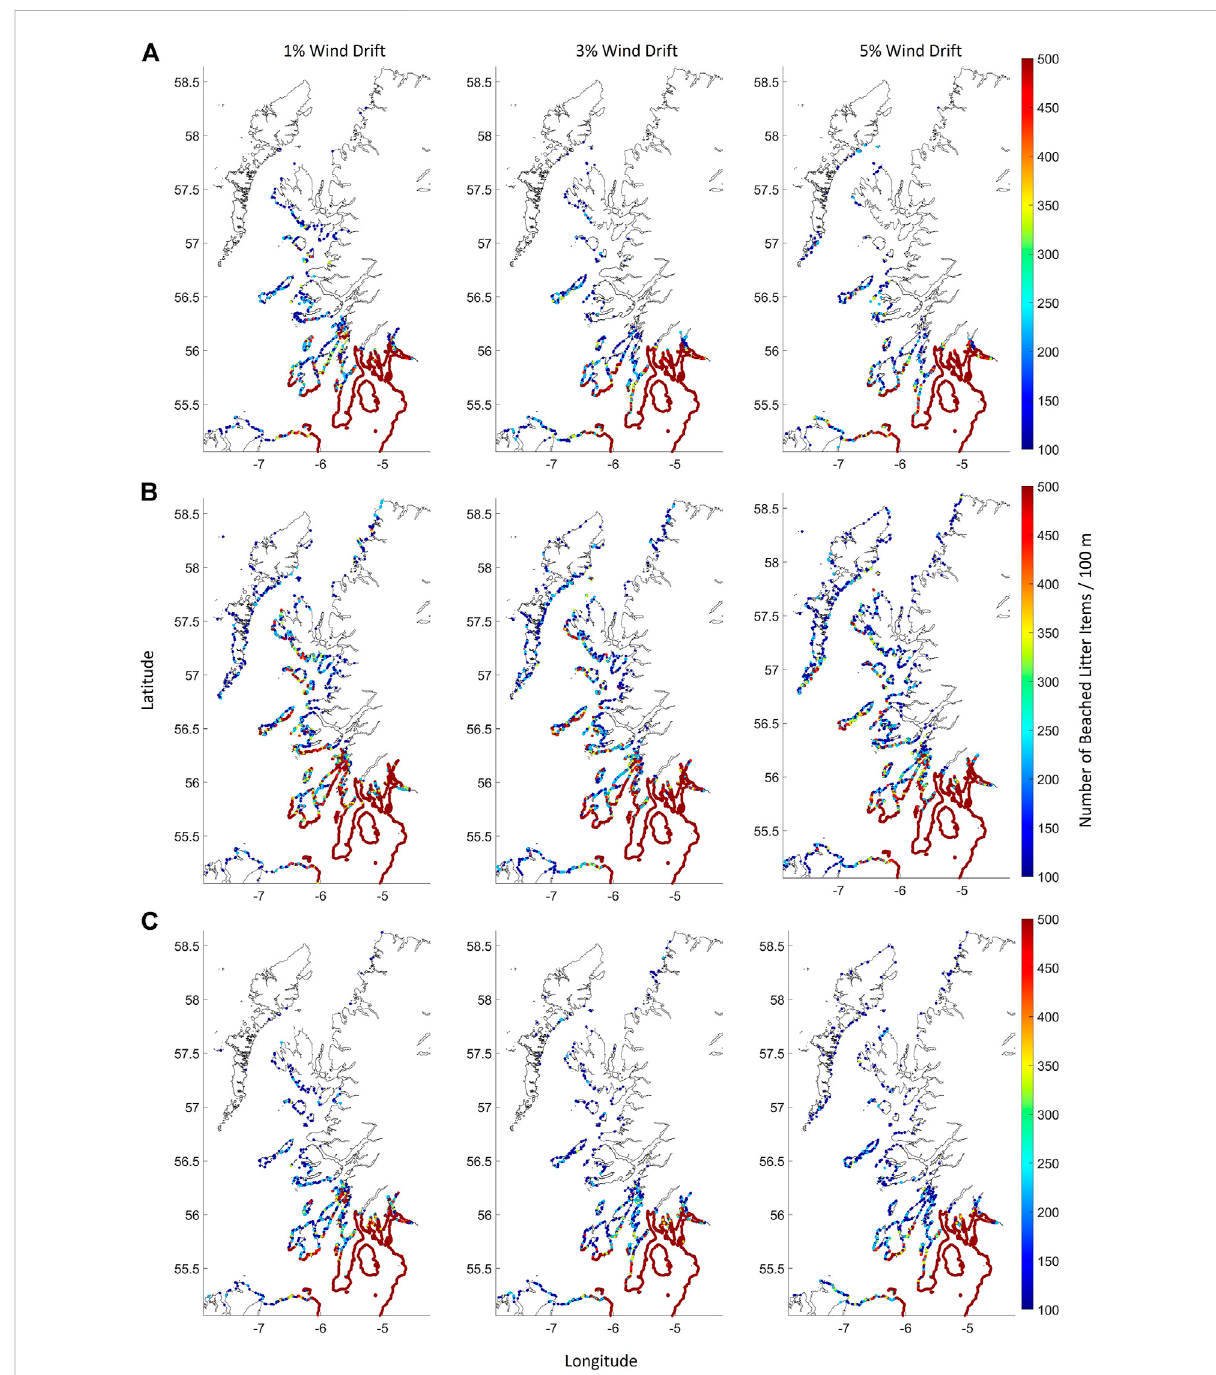
FIGURE 6 BeachingdistributionofNP/100 mwithinthemodelsub-area.Resultsarederivedfromtheparticletrackingmodelattheendofa1-yearmodel run (i.e., a countof the fi nal position of beached particles on day 365) for (A) sticky coastal boundary condition, (B) resuspending unclassi fi edcoastal boundary condition and (C) resuspending classi fi ed coastal boundary condition. It is important to note here the minimum value on the scale is 100 and the maximum value 6 × 10 4 . The scale has been adjusted to allow representation of lower values along the